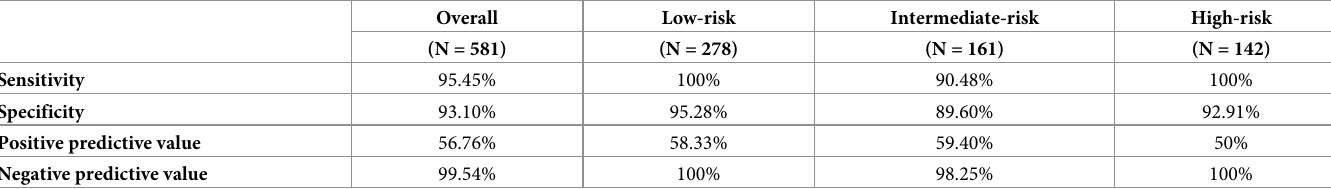
Table 6. Sensitivity, specificity, positive and negative predictive values of IOC in detecting CBD